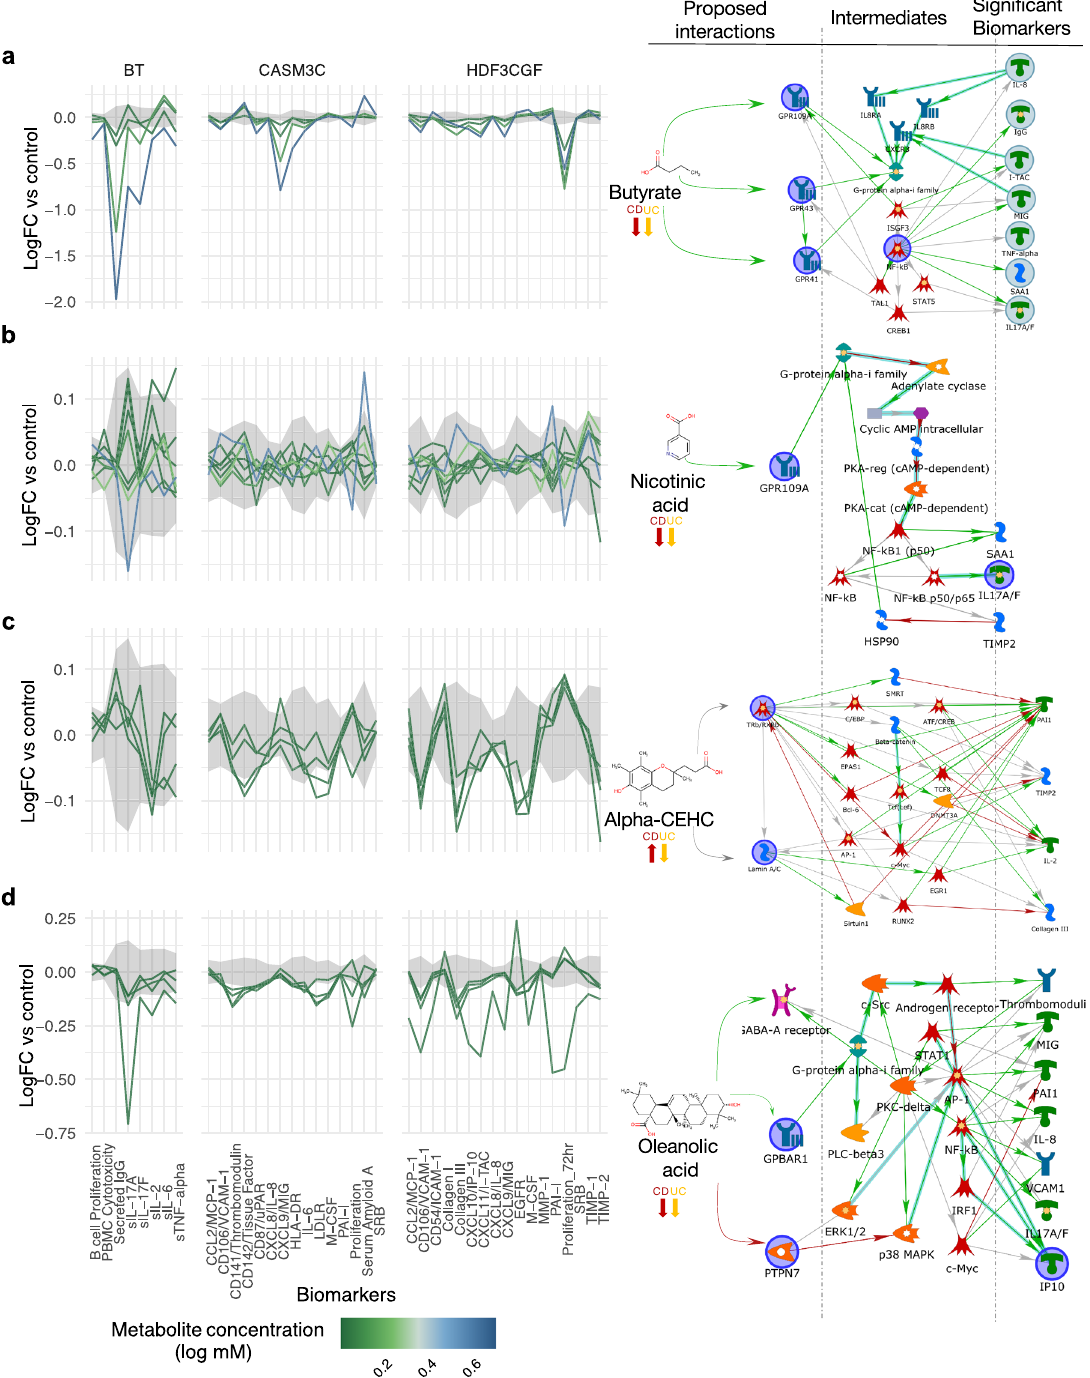
Fig. 5 Examples of biomarker readouts from in vitro cell assays for four of eleven tested metabolites. a Butyrate, b Nicotinic acid, c Alpha-CEHC and d Oleanolic acid. Metabolites were administered at different concentrations, here ranked from higher to lower (concentrations in Supplementary Data 8). Readouts graph show the differential abundance vs baseline for the B and T cell system (BT), arterial smooth muscle cells (CASM3C) and wound healing (HDF3CGF) (full results for all 11 metabolites are shown in Supplementary Fig. 6). Knowledge-based graphs on the right represent possible pathway connections between the proposed targets for each metabolite and the most signi fi cant biomarker readouts. Interactions are color-coded for positive (green), negative (red) and unknown (gray)